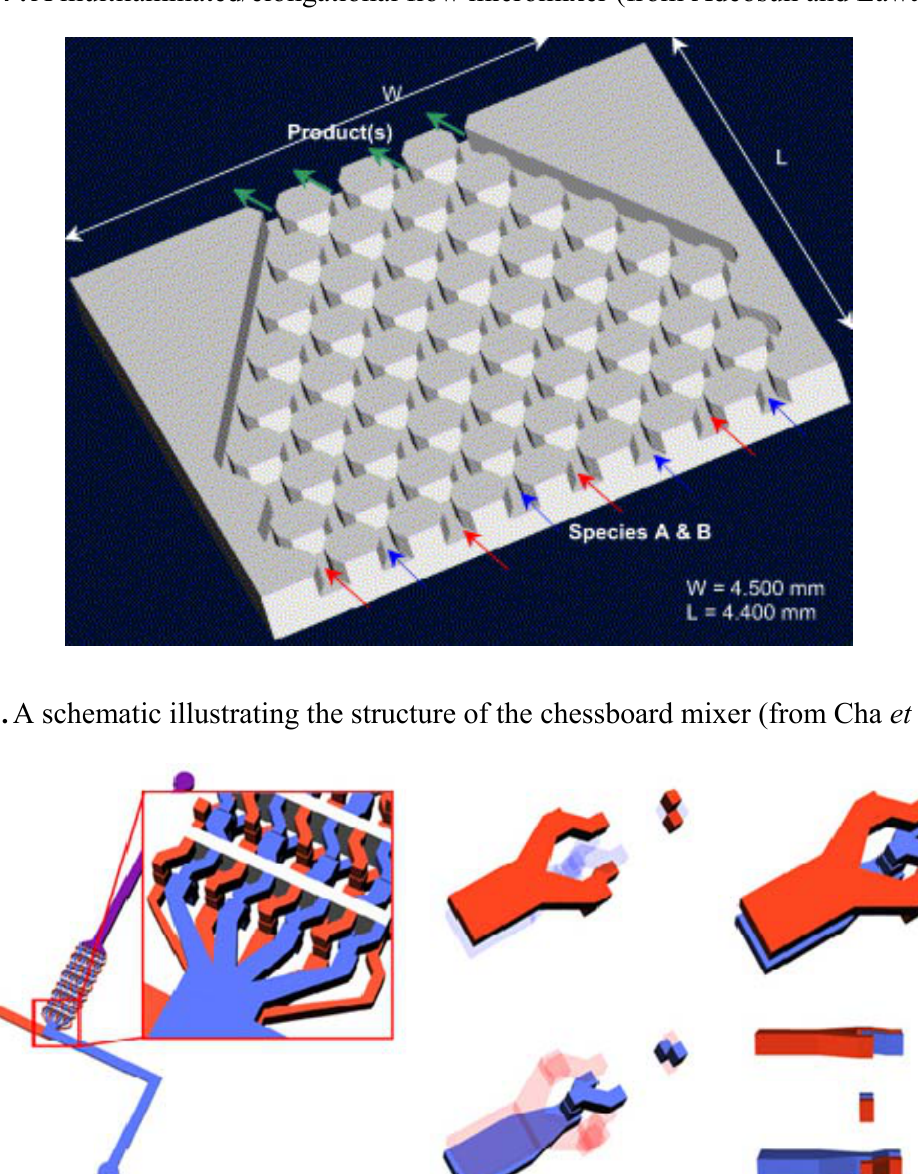
Figure 7. A multilaminated/elongational flow micromixer (from Adeosun and Lawal [10]).